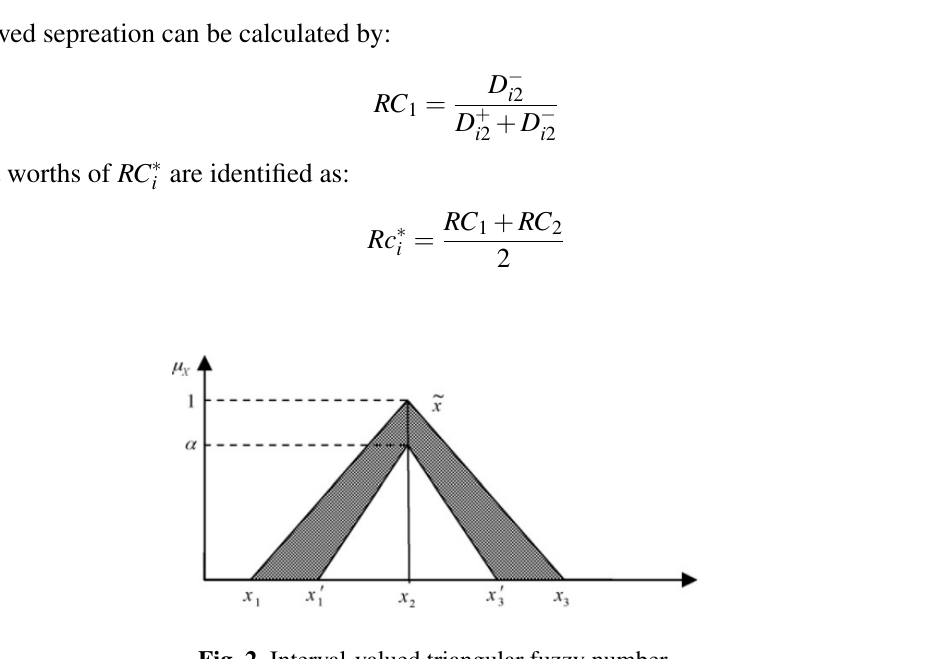
Fig. 2 Interval-valued triangular fuzzy